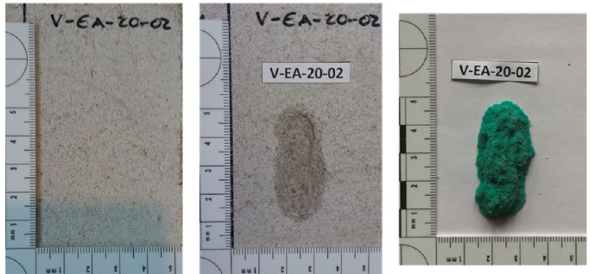
Fig. 7 Documentation of tests using sand-lime bricks (left: untreated brick, middle: treated brick, right: silicone mark of the hole)